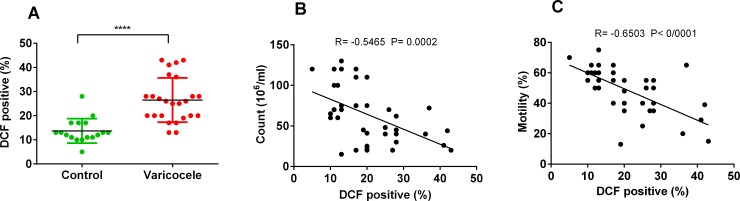
Determination of reactive oxygen species (ROS) levels in the varicocele and control groups and its relationship with sperm count and motility.(A) Reactive oxygen species (ROS) levels in the varicocele and control groups assessed by DCF-DA staining (****P<0.0001 using the unpaired t-test). ROS levels had a negative correlation with sperm count (B) and motility (C). Pearson’s coefficient was used for correlation assay.